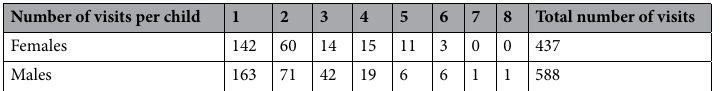
Table 3. Distribution of numbers of visits per